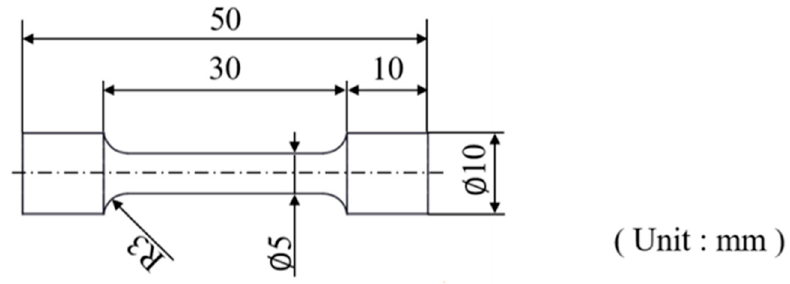
Figure 3. Diagram of the tensile test specimens.